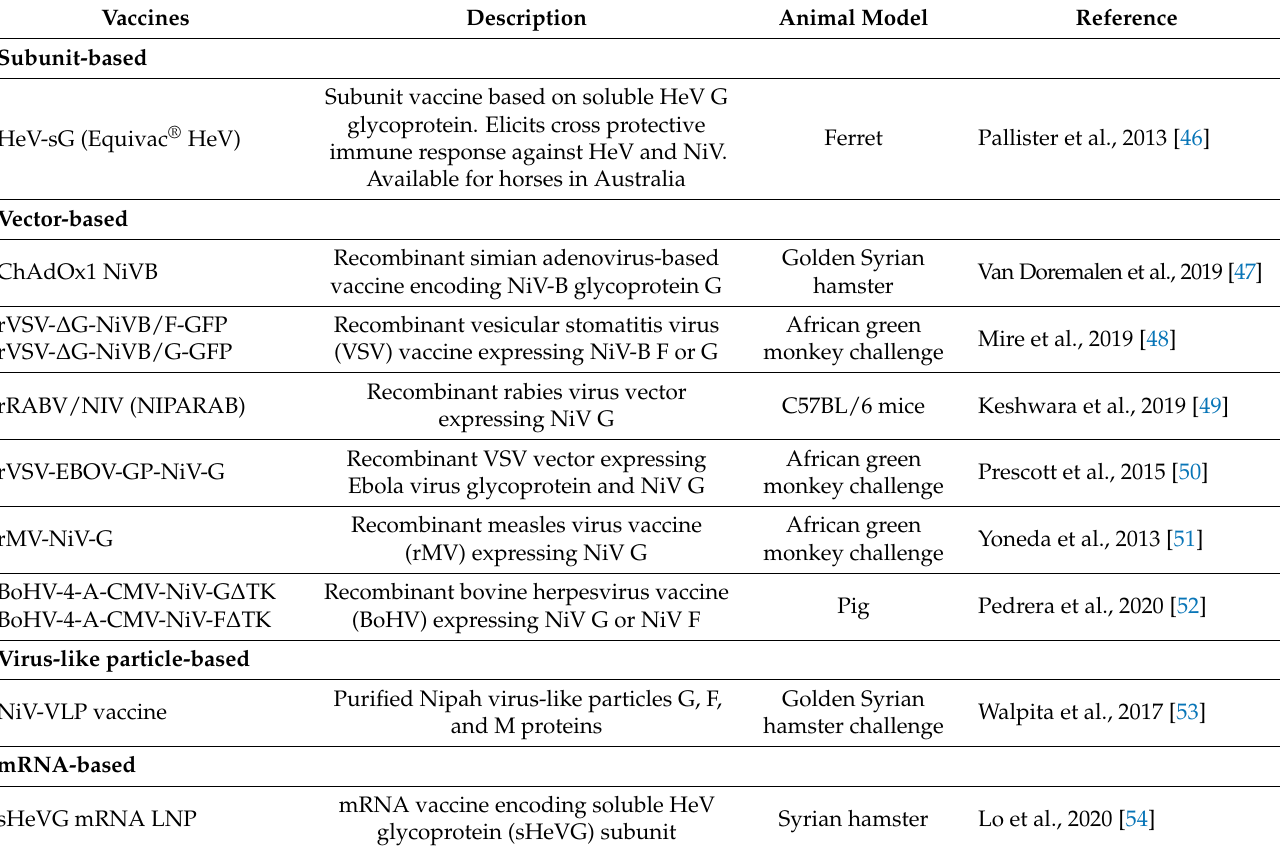
Table 3. Vaccines in development to prevent Nipah virus